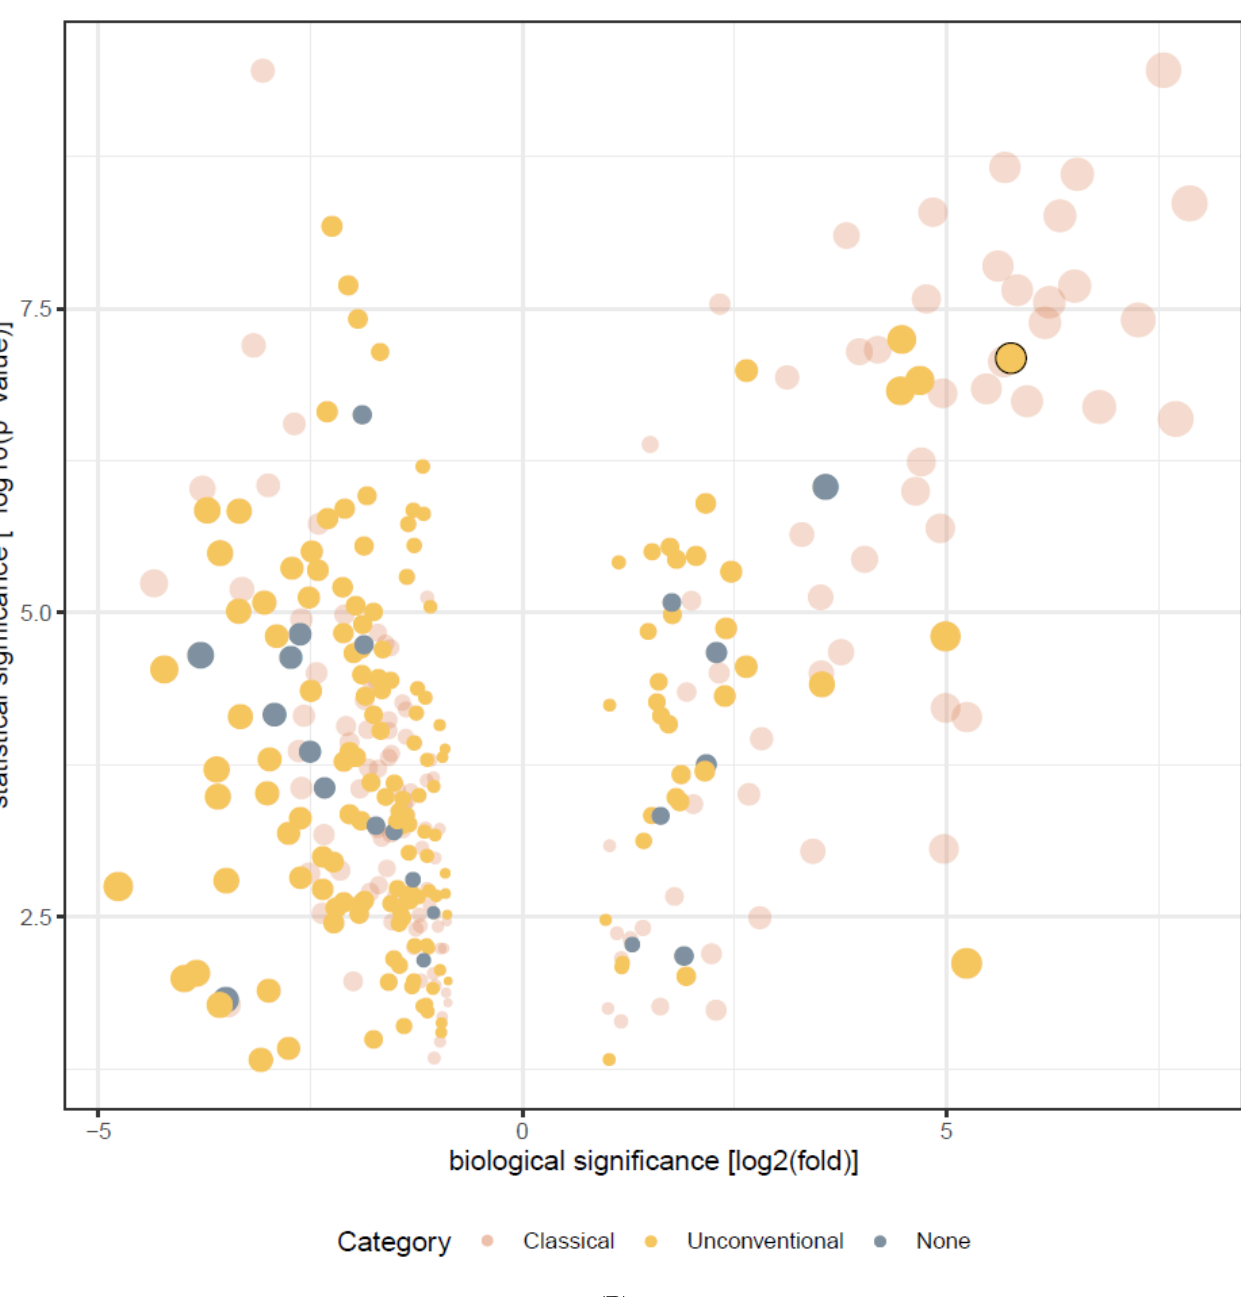
Figure 4. Tomato results. ( A ) UpSet plot of excess manganese secretome results indicating the concordance between predictions of LSPpred and SPLpred (including low-confidence modes), as well as SecretomeP. Agreement between the high- and low-confidence modes is implicit when assigned UPS by the high mode. ( B ) Partial recreation of Figure 2A from Ceballos-Laita [41], with a volcano plot of statistically significant (ANOVA, p < 0.05) proteins with changes to abundance are shown. Size is proportional to the log fold change and colour-coded by the new assignment of UPS category through use of all modules of SPLpred and LSPpred (light red = classical secretion, gold= unconventional secretion, grey = no secretion predicted). The Major allergen d 1 (Solyc09g091000.3.1) is marked by a black circle.